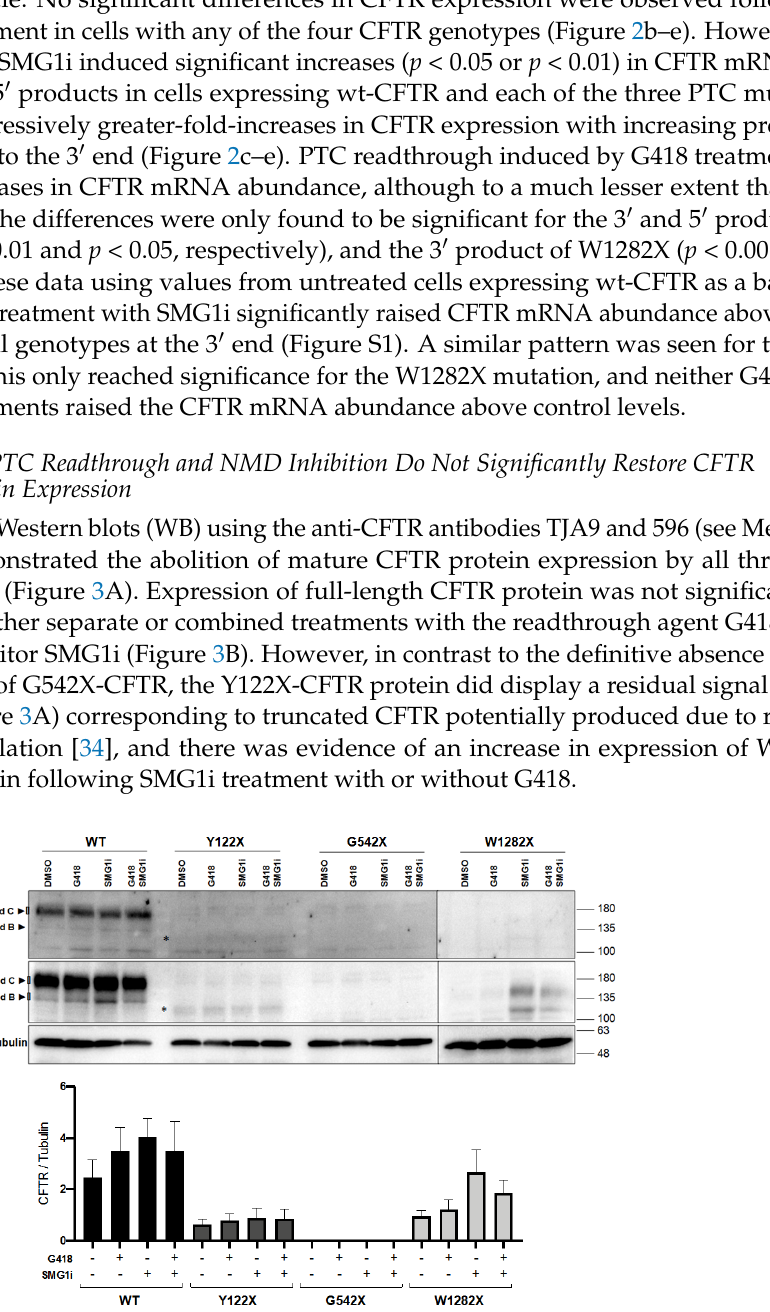
Figure 3. Expression of CFTR protein following treatment with G418 and/or SMG1i. ( A ) Representative Western Blot analysis of CFTR protein expression in 16HBE cells expressing wt-CFTR or Y122X, G542X, and W1282X-CFTR mutations following treatment with G418 (500 µ g/mL) and SMG1i (1 µ M) for 24 h. CFTR was detected using first the anti-CFTR TJA9 (1:500), which recognizes the ECL1 domain (upper panel), and then reblotted with the anti-CFTR 596 (1:3000), which recognizes the NBD2 domain (middle panel). Images were acquired using ChemiDoc XRS+ imaging system (BioRad) and further processed by Image lab 4.0 software ( n = 3). ( B ) For blots incubated with 596 antibody, densitometry was used to quantify total CFTR (band C + band B) and normalized to the loading control ( α -tubulin). Data shown as mean ± SEM ( n = 3). Asterisks in ( A ) indicate truncated CFTR potentially produced due to reinitiation of translation (~128